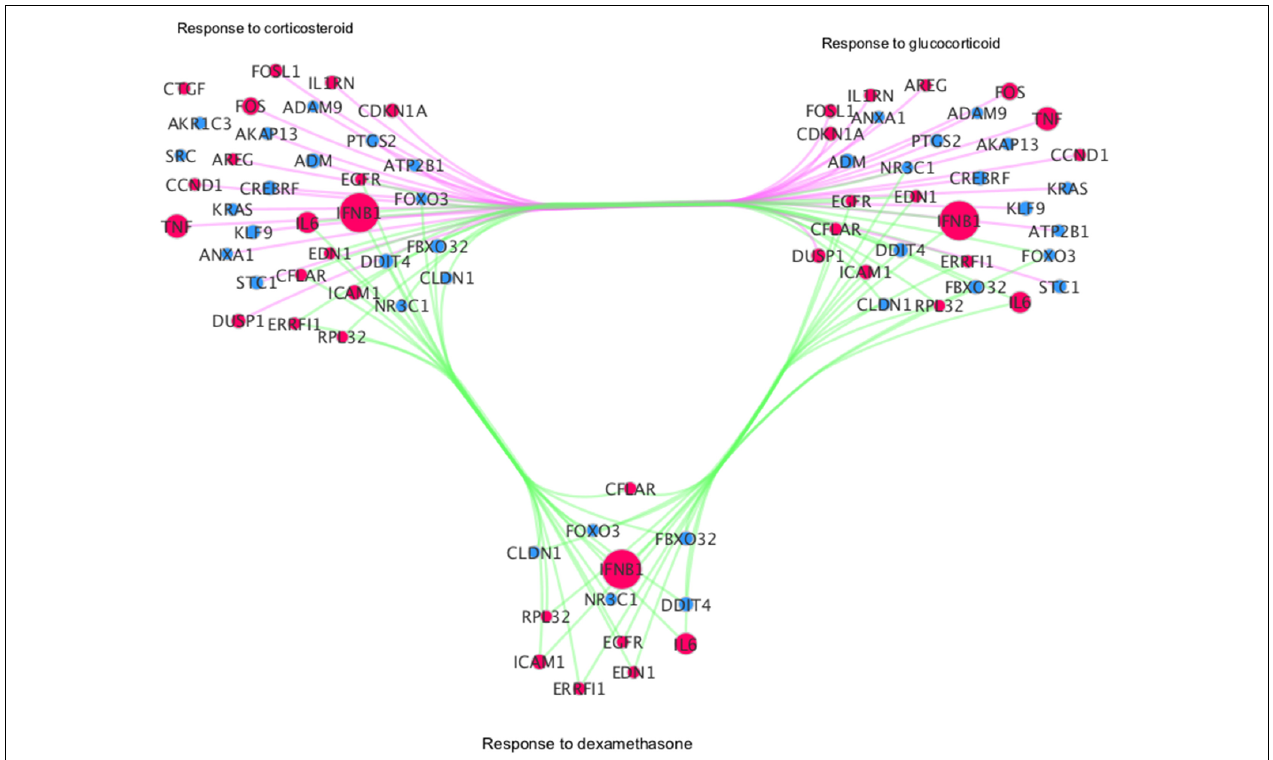
FIGURE 5 | Network visualization of GSEA derived categories related to steroid biosynthesis. Red: up-regulated, Blue: down-regulated; Size: log2 fold change. Green edges: gene is shared among all categories; magenta: genes are only shared among response to corticosteroid and response to glucocorticoid